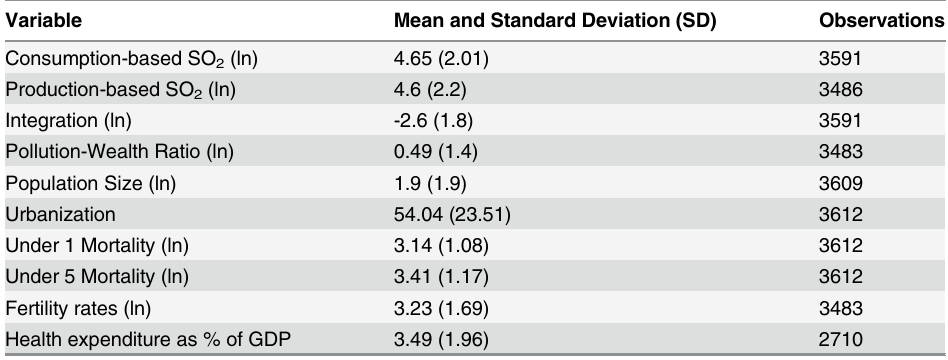
Table 1. Descriptive Statistics for all Variables. Variable Mean and Standard Deviation (SD)